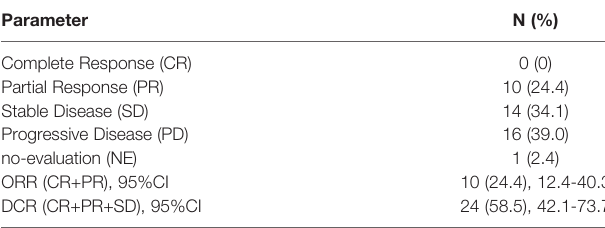
TABLE 2 | Overall tumor response in patients.